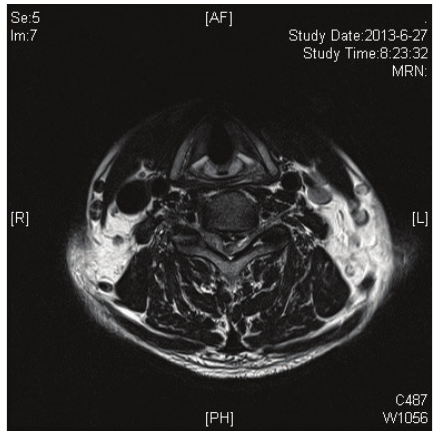
Figure 3: T2-weighted axial magnetic resonance image. The spinal cord is markedly compressed by a large disc herniation-like mass on the left side, with lateral displacement of the cord to the right. Zones of CSF signal intensity material (“halo”) are noted adjacent to the mass.